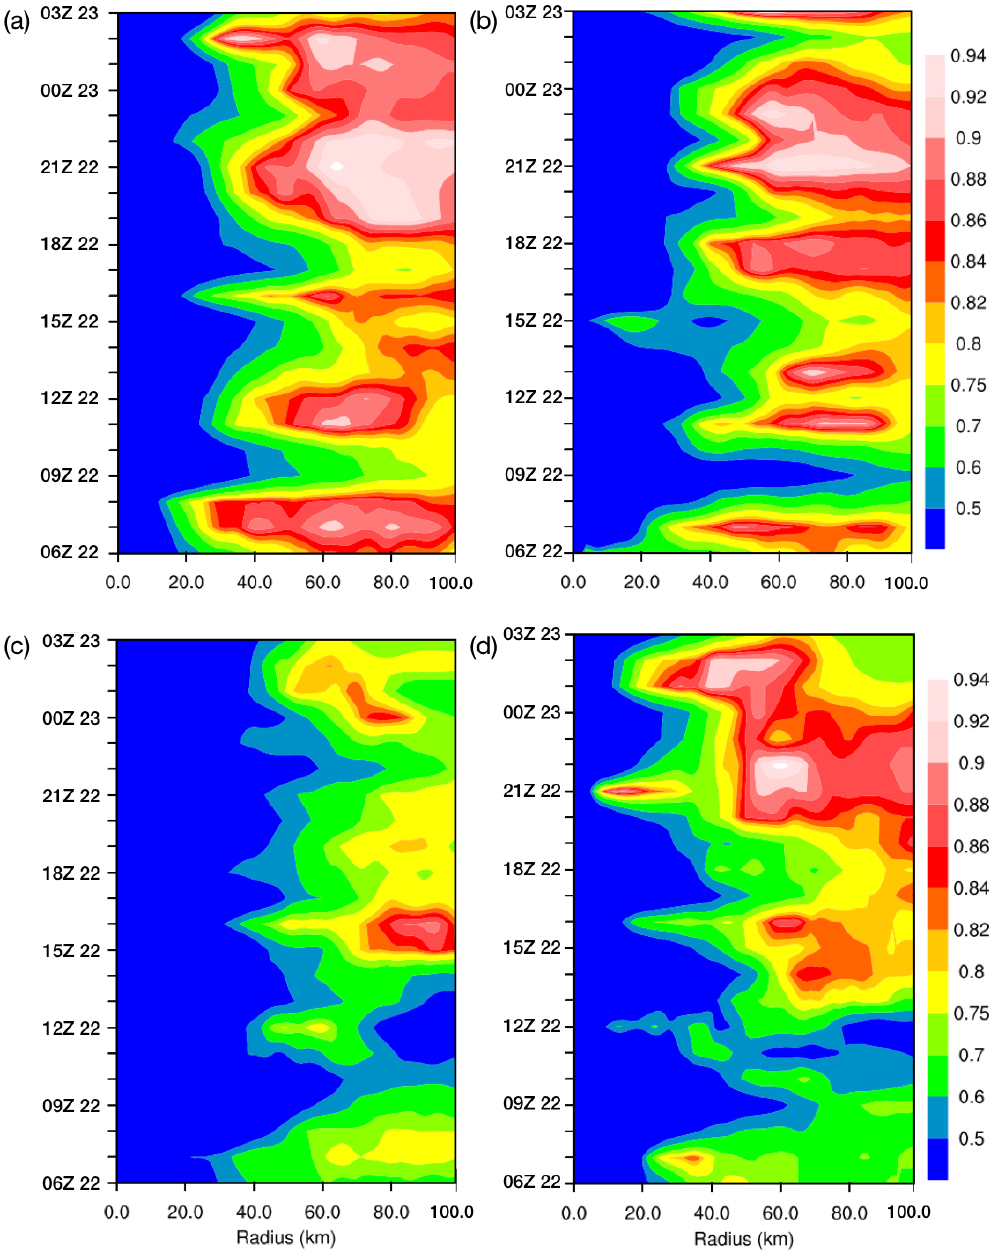
Figure 11. Evolution of the azimuthally averaged axisymmetry parameter (shade) at 6.5 km altitude (upper row) and 12.0 km altitude (lower row) for the CPL ( a , c ) and FO experiments ( b , d ). Ordinate values are time from 0600 UTC on 22 August to 0300 UTC 23